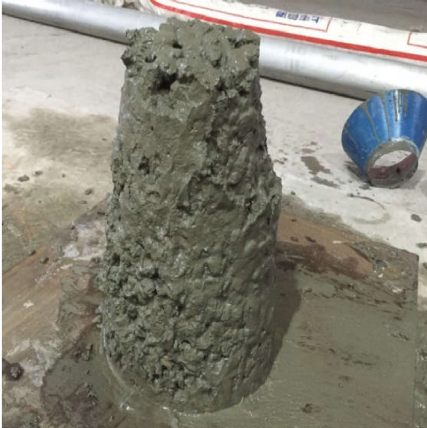
Figure 5: Photograph of the concrete mixture’s slump.